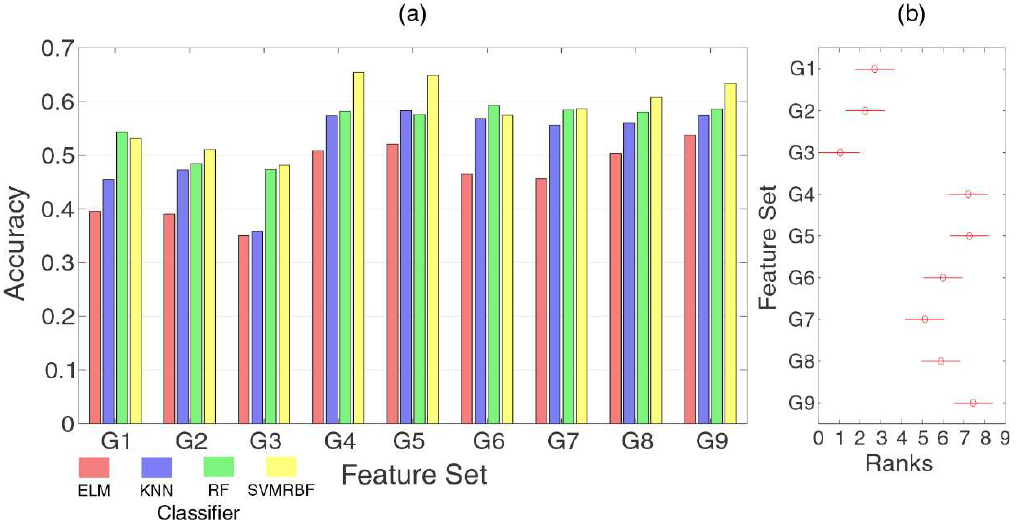
Figure 7. ( a ) Accuracies for the selected features sets (G1 to G9) for the classifiers that presented the highest accuracies in the previous analysis. ( b ) Distributions for the Tukey post-hoc from Friedman statistical test to evaluate the distribution of results with a confidence interval of 95% ( p -value < 0.05). Two sets of ranks can be observed, separating G1 to G3 and G4 to G9. One can note that the feature sets G4, G5, G6, G8, and G9 have similar distributions.